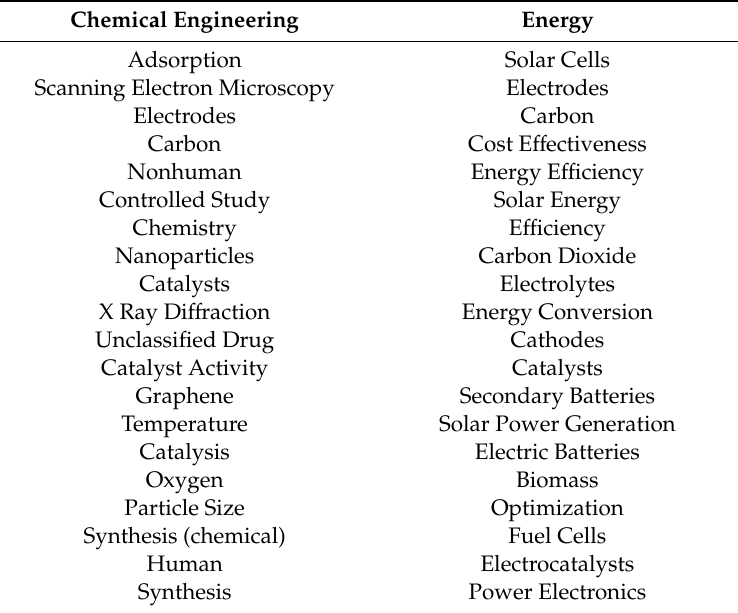
Table 10. Keywords on low cost research for the categories 7 and